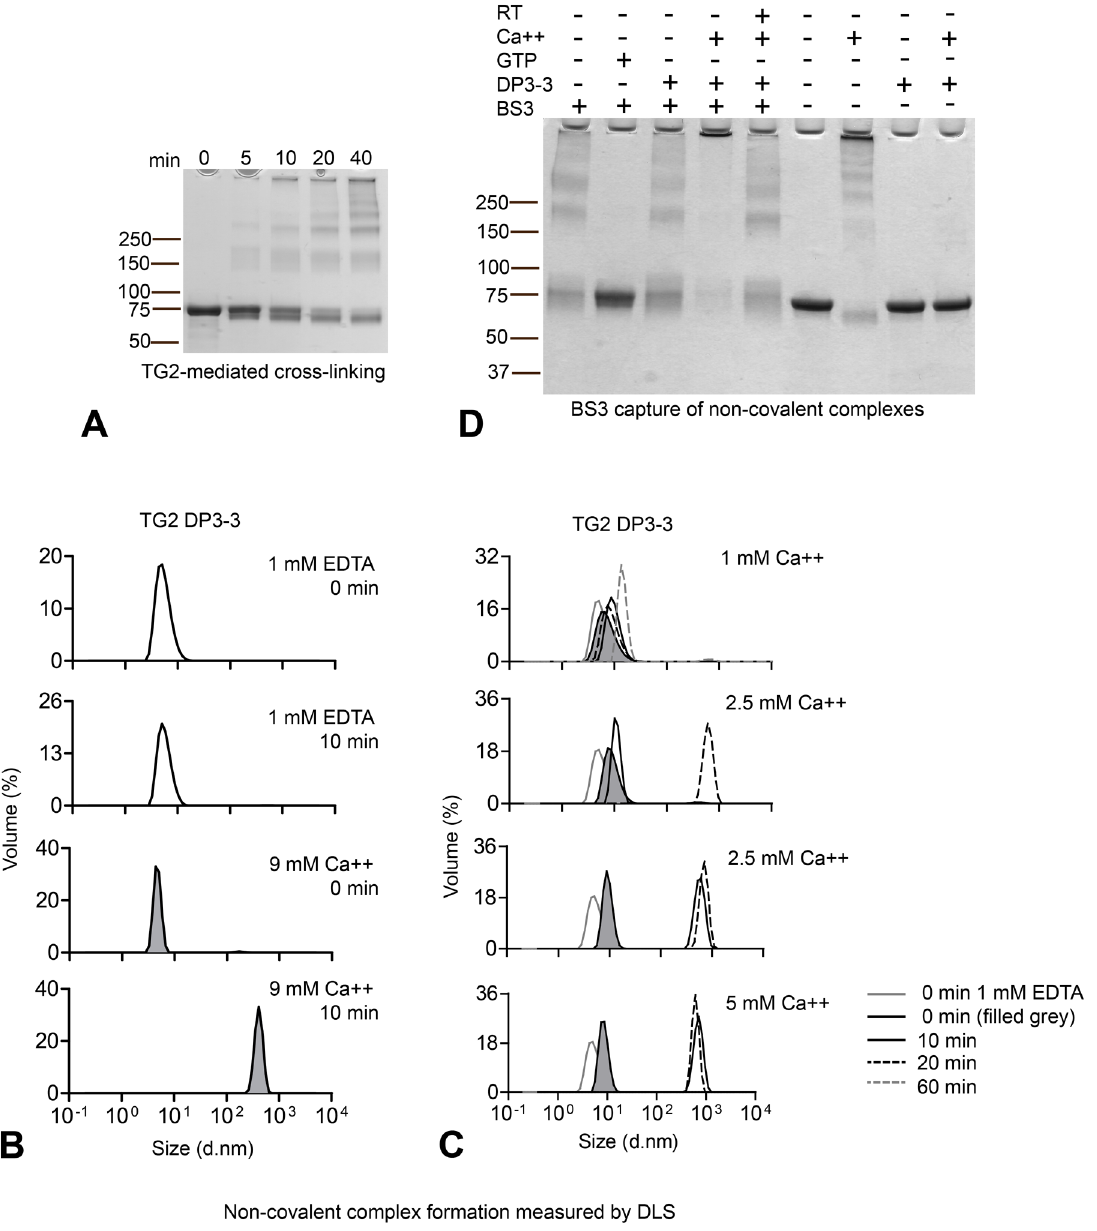
Fig 2. Homotypic TG2 association is conformation dependent (A) TG2 (2.4 μ M) self-crosslinking over time occurs via initial formation of dimer and trimer as observed after 5 and 10 min. (B) Inactive, inhibitor bound TG2 produced in E . coli (TG2-DP3-3) was incubated at 37°C in the presence of 1 mM EDTA or 9 mM CaCl 2 and aggregation was measured by DLS. The graphs display volume percentage (Y axis) and size as diameter (d. nm) on the X-axis. Incubation with 9 mM CaCl 2 at 37°C results in aggregation formation already after 10 min. (C) Titration of CaCl 2 was performed at 37°C and non-covalent complex formation was compared at different time-points: 0 min (black line, grey fill), 10 min (black solid line) and 20 min (black dotted line). For 1 mM CaCl 2 , 60 min incubation is also shown (grey dotted line). The solid grey line shows TG2-DP3-3 incubated in 1 mM EDTA at time 0 min for comparison. Two datasets from the same experiment are shown for 2.5 mM CaCl 2 as variation was observed in the degree of high molecular weight multimer formation for this CaCl 2 concentration. (D) Capture of non-covalent TG2-TG2 associations using BS3 cross-linking reagent. TG2 was incubated in the absence of effectors or together with 5 mM CaCl 2 or 1 mM GTP for 30 min at 37°C or, where indicated, for 30 min at room temperature (RT) before addition of BS3. To avoid enzymatic self-crosslinking in the presence of Ca 2+ the enzyme was pretreated with the active-site inhibitor DP3-3. Incubation of TG2-DP3-3 with CaCl 2 at 37°C followed by BS3 treatment results in the formation of large complexes that do not migrate through the gel.